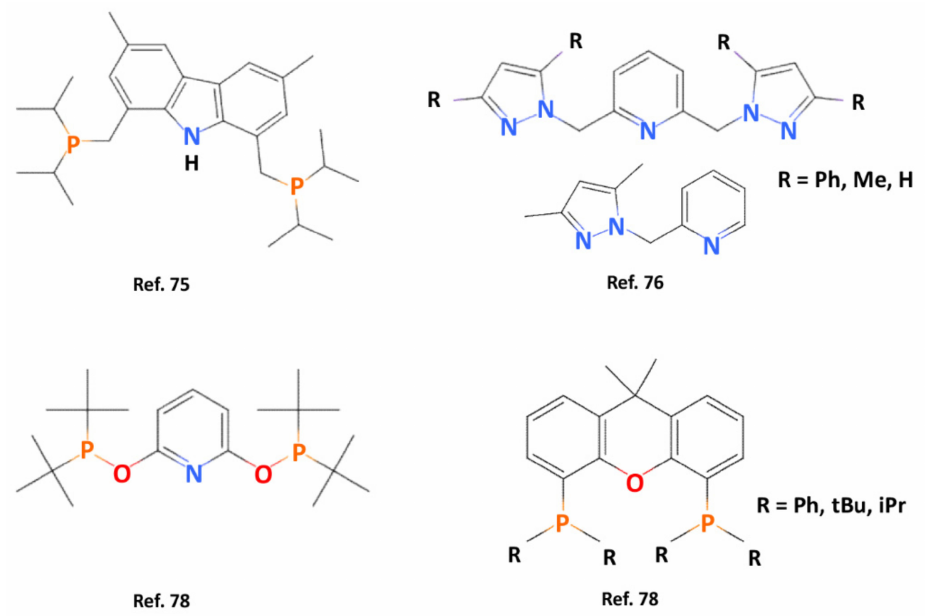
Figure 5. Molecular structures of some pincer ligands in recent